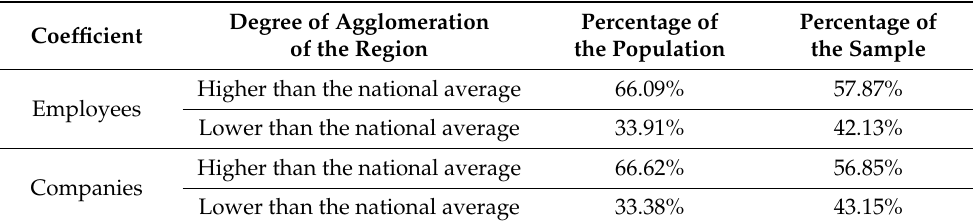
Table 2. Comparison of the distribution of the population and the sample in relation to the degree of agglomeration of the sector under study, in relative values.